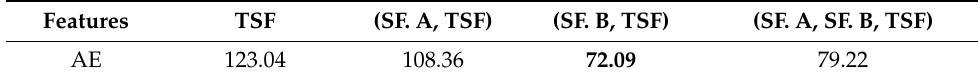
Table 5. AE of fused